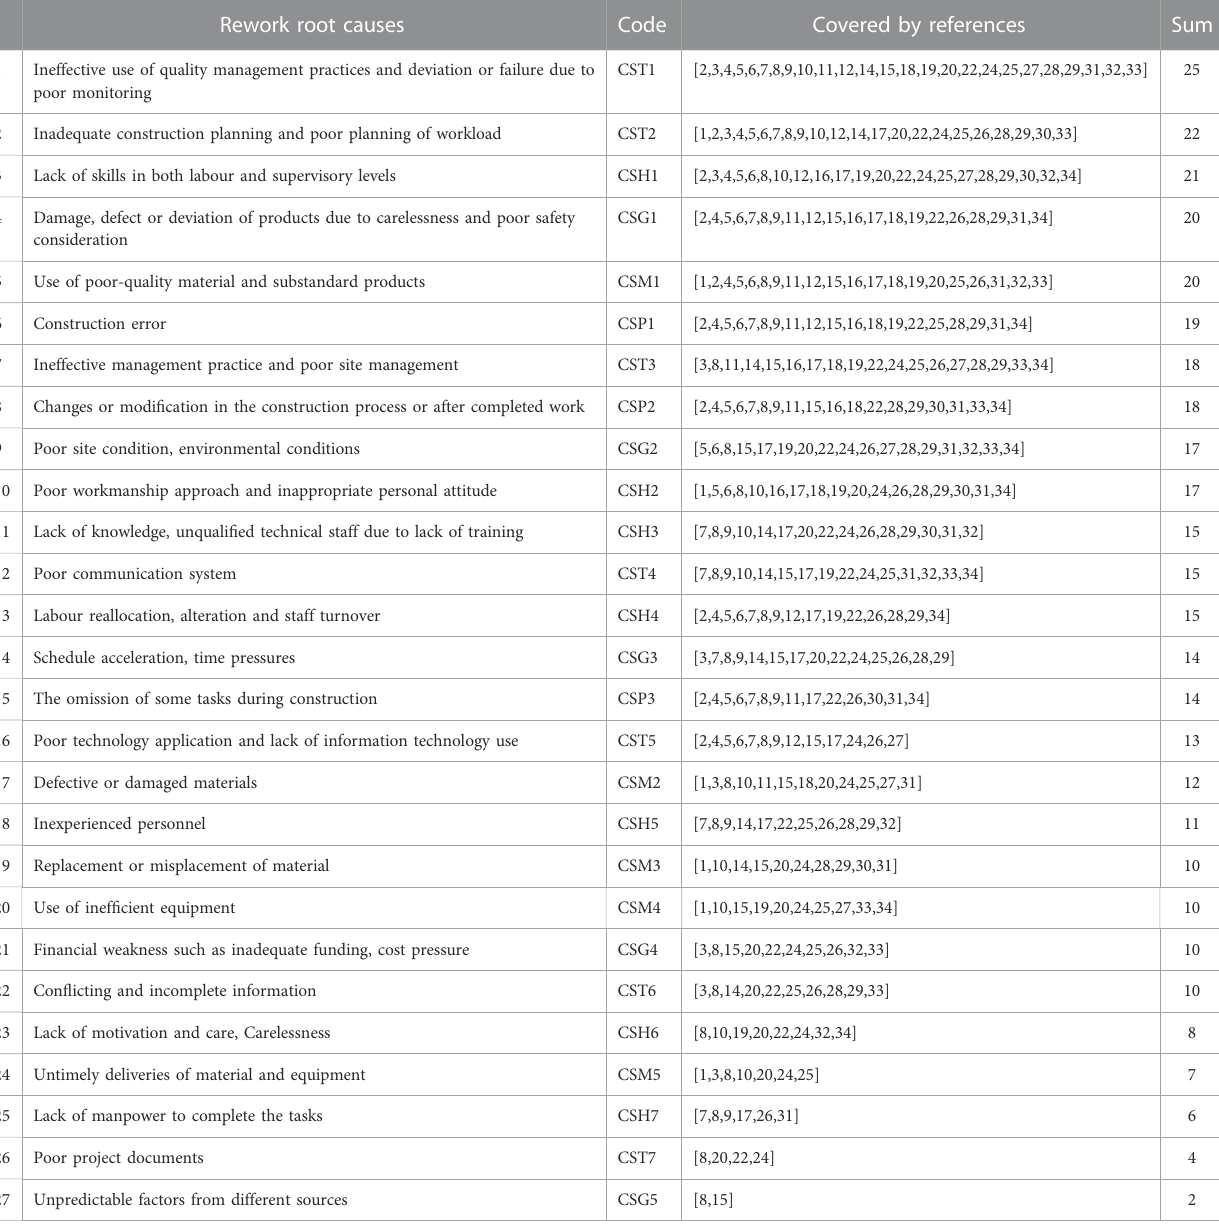
TABLE 7 Rework causes classi fi cation in construction stage — liable to the contractor-side of the